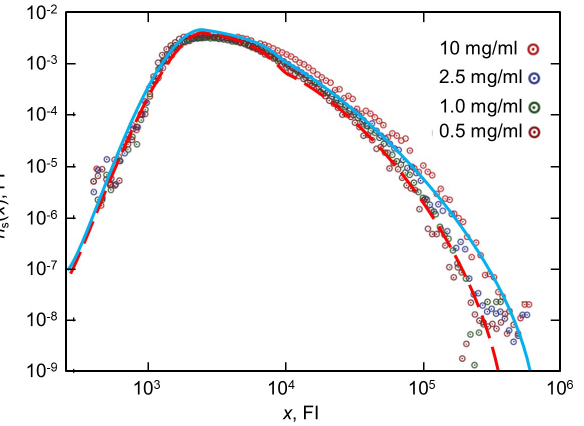
Figure 1. Theory (expression (22)) is compared with experimental distribution (Figure 3E in Ref. [10]) after 45 min internalization of low-density lipoprotein (LDL) for four different LDL concentrations: γ = 0.0015 s − 1 ; K = 0.00016 s − 1 , x 0 = 450 FI; J = 546 FI s − 1 (blue solid line) and J = 300 FI s − 1 (red dashed